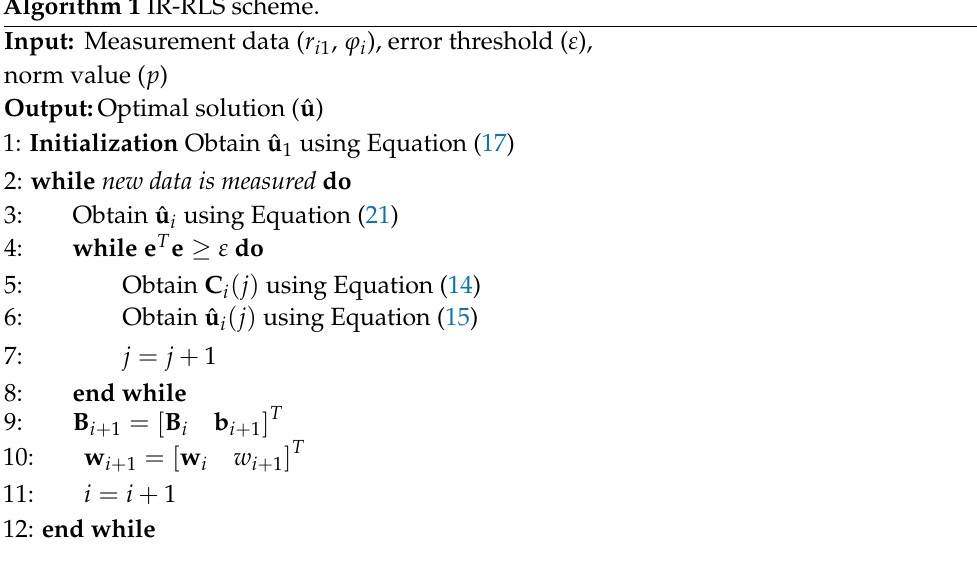
Figure 1. Flowchart of the iteratively reweighted-recursive least squares (IR-RLS) procedure. Algorithm 1 IR-RLS